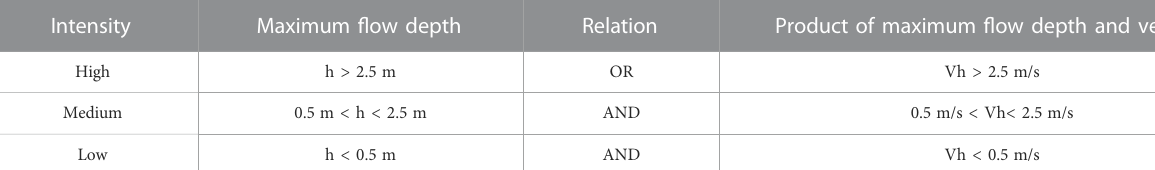
TABLE 2 Classi fi cation standard of debris fl ow.